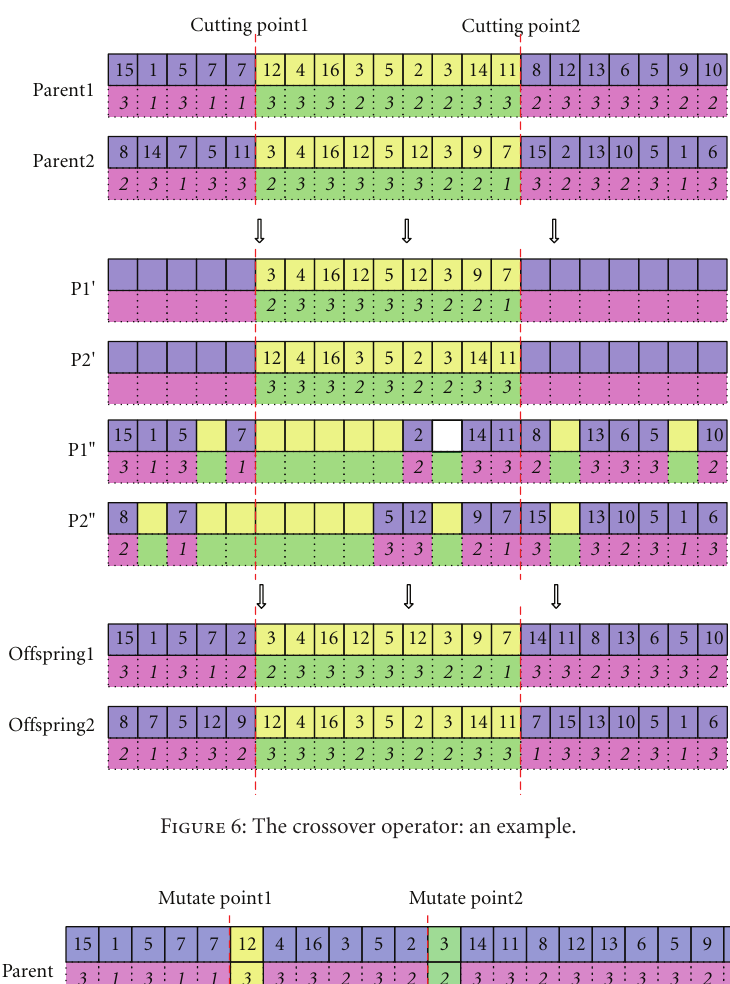
Figure 6: The crossover operator: an example.